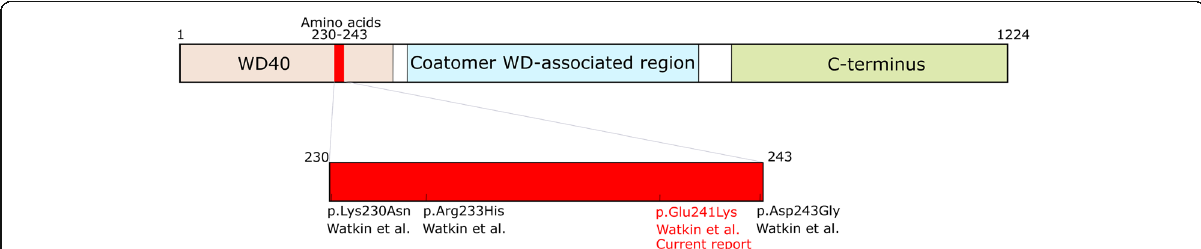
Fig. 1 Illustration of the COPA protein. Previously reported mutations in COPA (Watkin et al., 2015) all cluster within a 14 amino acid stretch in the COPA protein. The mutation detected in the Icelandic pedigree is listed in red. The current report marks the second observation of the p.Glu241Lys mutation